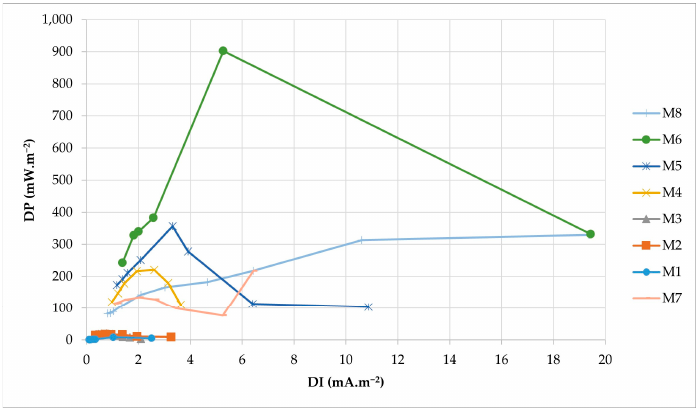
Figure 6. Polarization curves of each MFC at the end of open-circuit operation.